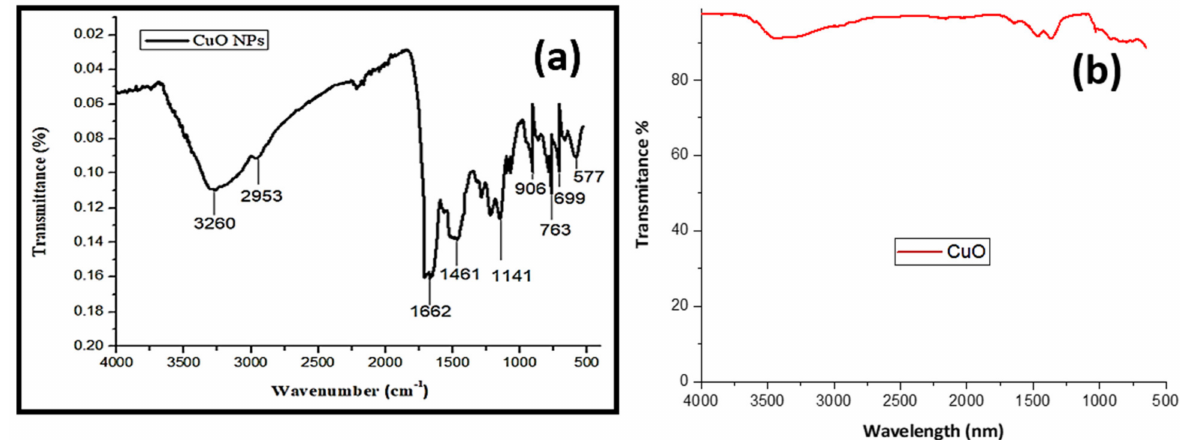
Figure 6. ( a ) FTIR spectra of plant extract ( b ) FTIR spectra of CuO NPs.